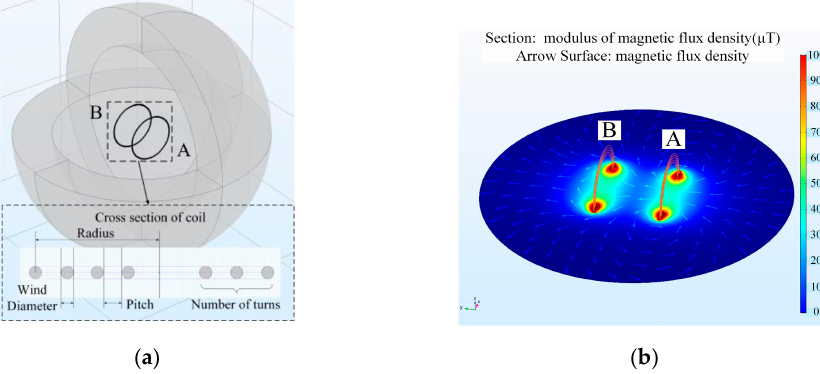
Figure 4. ( a ) Simulation model and ( b ) magnetic field model of WPT system.